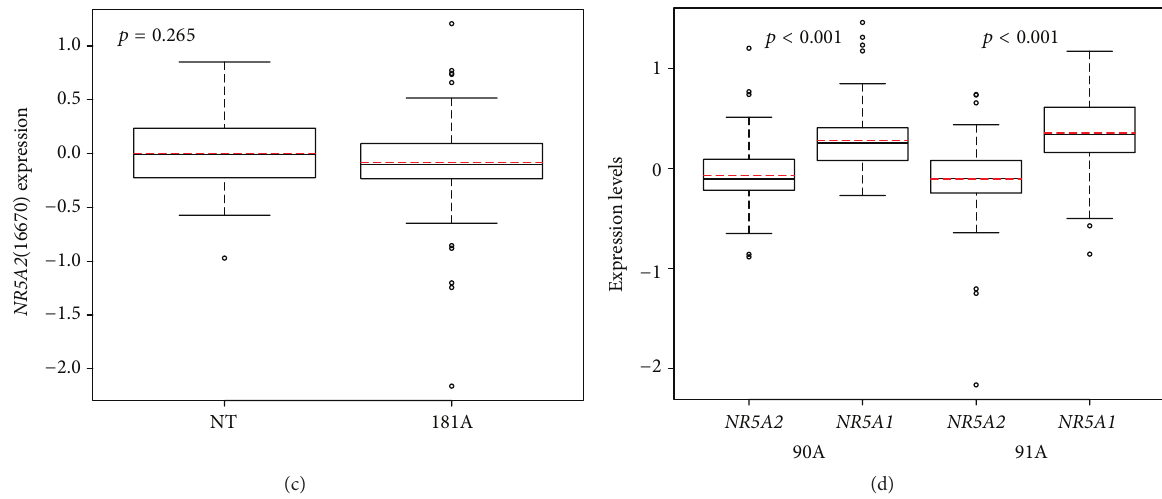
Figure2:Clinicalimpactof NR5A2 intwocohortsofinfiltratingductalbreastcarcinomas.ANOVAtestresultsof NR5A2 (16670)mRNAlevels in eight clinical indices: progesterone receptor (PR), HER-2/neu (HER), lymphovascular invasion (LVI), lymph nodal category (lymph node metastasis status (LYM), number of lymph node metastases (LNM)), age, tumor size (size), histological grade (grade), nuclear pleomorphism (NP), mitotic count (MC), tubule formation (TF), and cancer stage in 91A cohort and 181A cohort, respectively (a, b). (c, d): box plot analysis of NR5A2 (16670) mRNA levels in two cohorts (i.e., nontumor component (NT) and 181A cohort) (c). The number on the 𝑦 -axis inside the box plot C stands for the expression level of NR5A2 . The 𝑥 -axis for each box stands for 25 nontumor (NT) and 181A cohorts, respectively. Box plot analysis for pairwise comparison of NR5A2 (16670) mRNA levels and NR5A1 (652) mRNA levels in three cohorts (i.e., 90A cohort, 91A cohort, and 181A cohort) (d). The number on the 𝑦 -axis inside the box plot D stands for the expression level of the given TF which is listed in the 𝑥 -axis, respectively. The red dot line within the box is the mean value for each subgroup in the plot. The black line within the box is the median value for each subgroup in the plot. The Agilent feature number for NR5A2 is 16670. 652 is the Agilent feature number for